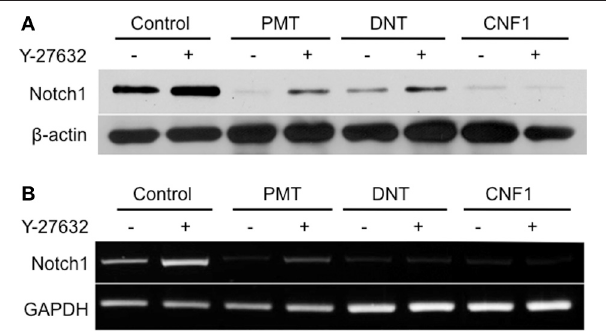
FIGURE 4 | Effect of dermonecrotic toxins on Notch1 signaling in 3T3-L1 cells. Confluent 3T3-L1 preadipocytes were treated for one day without (control) or with 1nM of the indicated toxin in the absence or presence of 10 μ M Y-27632. (A) Cell lysates were subjected to SDS-PAGE and immunoblot analysis using antibodies against Notch1 or β -actin (as control). (B) Cell lysates were analyzed for mRNA levels for Notch1 or GAPDH (as control) by